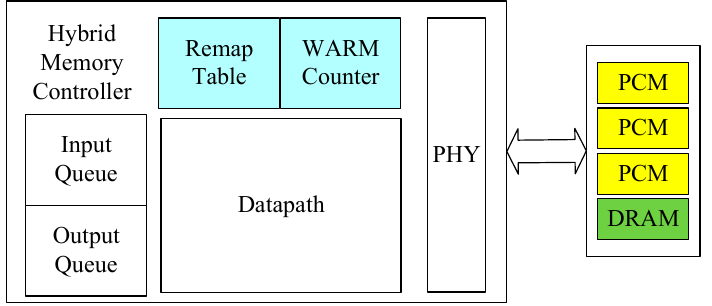
Figure 5. Memory controller architecture.